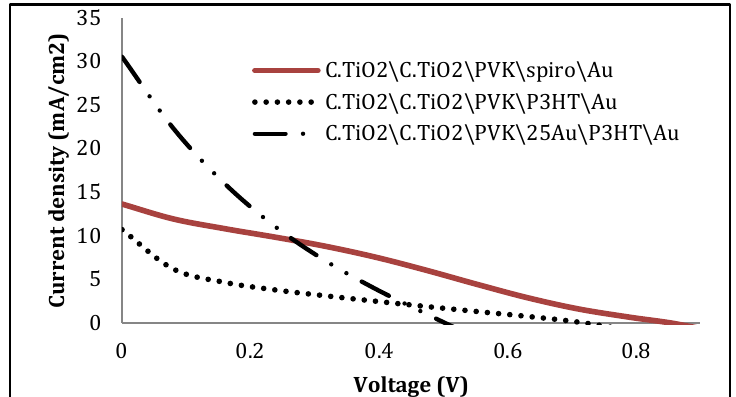
Figure 7: J-V characteristics of PSKs with thin Au layer between P3HT HTL and PSK.